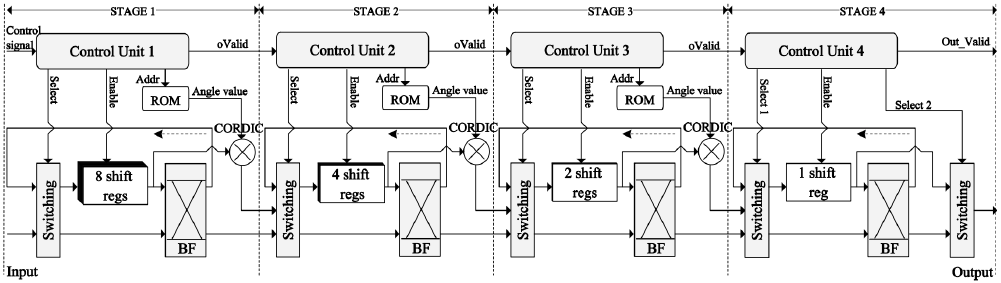
Figure 9. The proposed R2FB pipelined FFT processor for 16 points on field-programmable gate array (FPGA) hardware. Electronics 2018 , 7 , x FOR PEER REVIEW